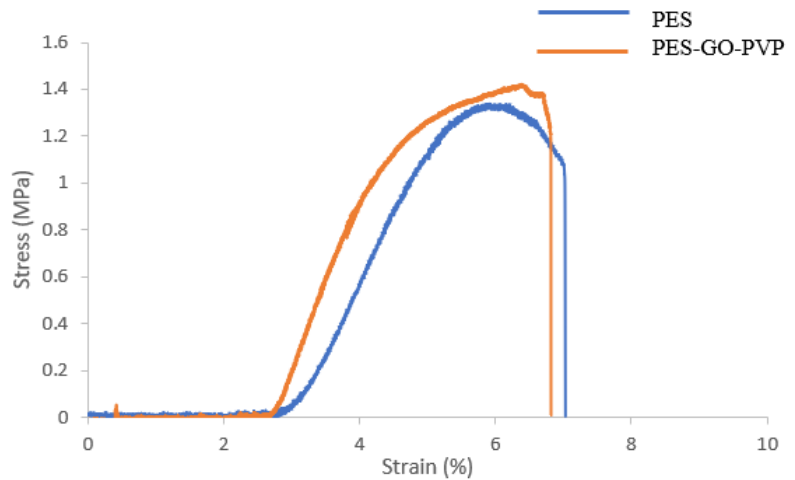
Fig. 6. Tensile strength of bare PES and PES-GO-PVP membranes plotted as stress vs